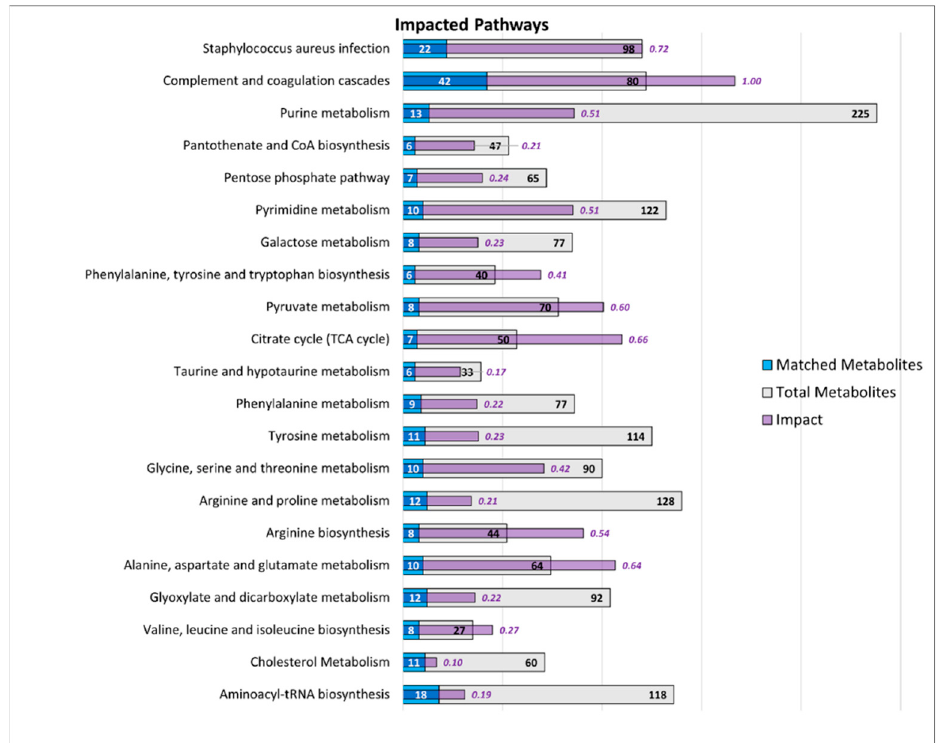
Figure 5. Significant pathways expressed in plasma from AD and MCI (compared with CN). The number of components of each pathway is presented as “Total metabolites” (grey bars) and the number of molecules matched to these pathways are presented as “Matched Metabolites” (blue bars). The “Impact” value represents the extent to which these pathways are impacted with the disease.